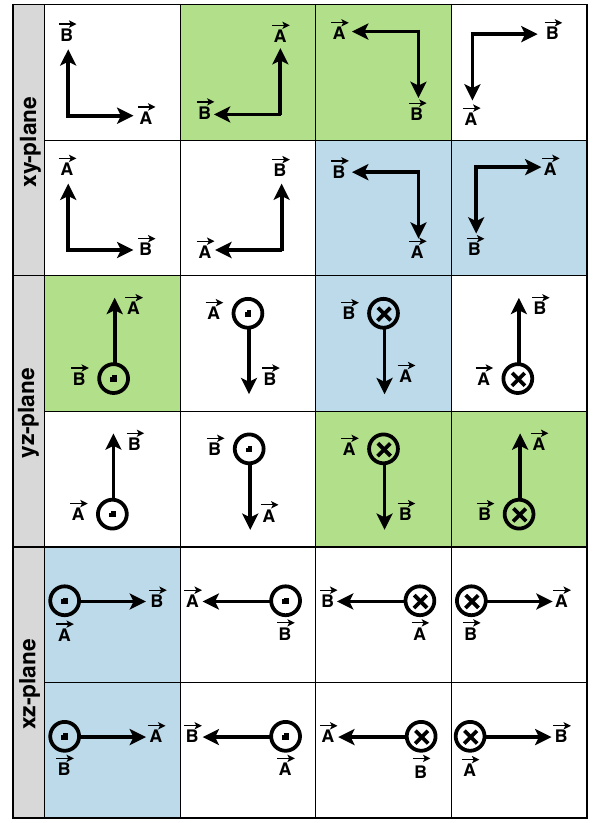
FIG. 4. All possible cross product combinations for on-axis, ~A ~B perpendicular vectors ( × ). The green orientations were the five orientations with the lowest average ranking for physical awkwardness ( Easy orientations) and the blue orientations were those with the highest average ranking for physical awkwardness ( Awkward